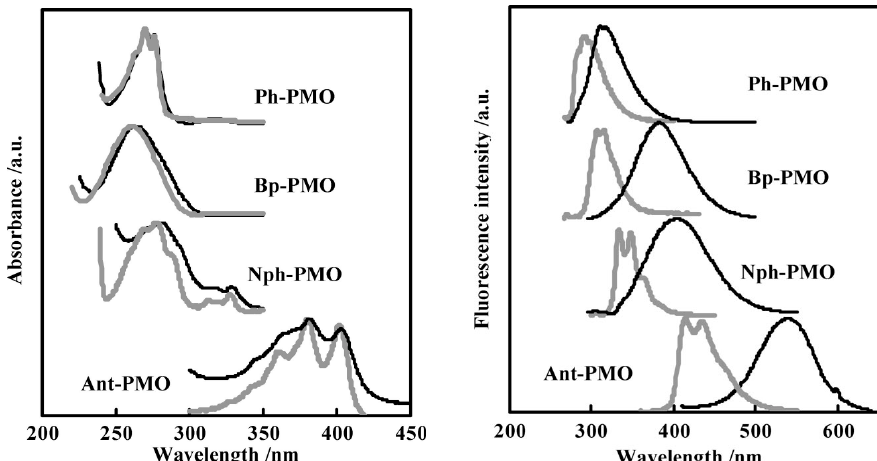
Figure 3. ( Left ): Absorption spectra of the benzene (Ph)-, biphenyl (Bp-), naphthalene (Nph)- and anthracene (ant)-PMO films and their precursors in 2-propanol (around 10 − 5 M). ( Right ): Fluorescent spectra of the same PMO films and their precursors also in in 2-propanol. [18].